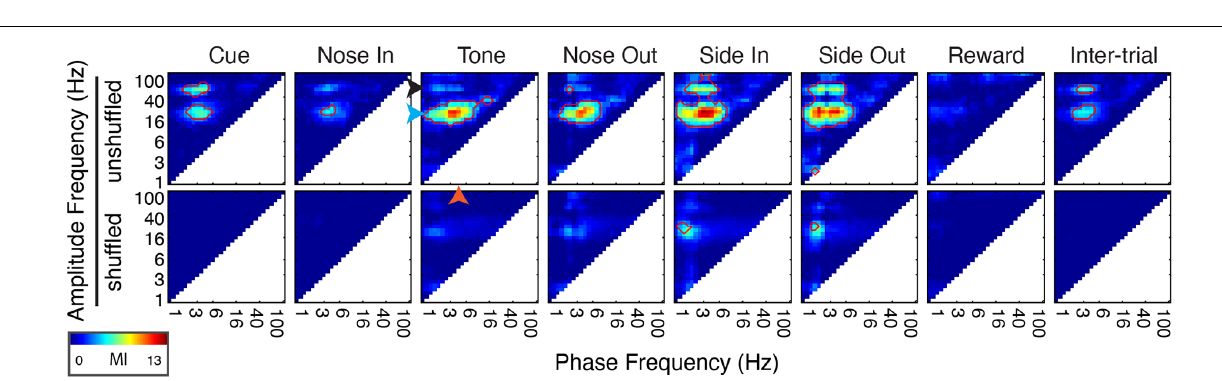
( µ baseline ) and standard deviation ( σ baseline ) of FP power from a surrogate distribution of power at randomly selected